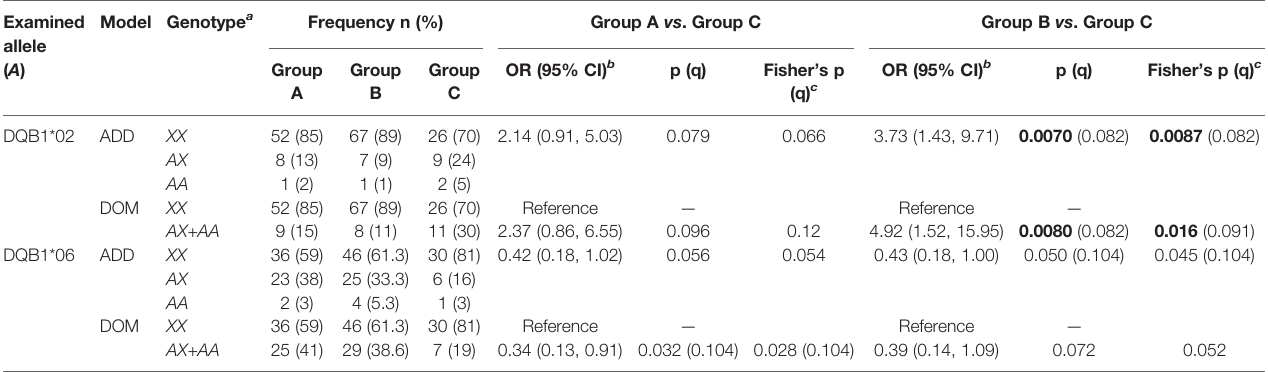
TABLE 4 | Signi fi cant associations of DQB1 alleles with effects of the HBV vaccine. Examined